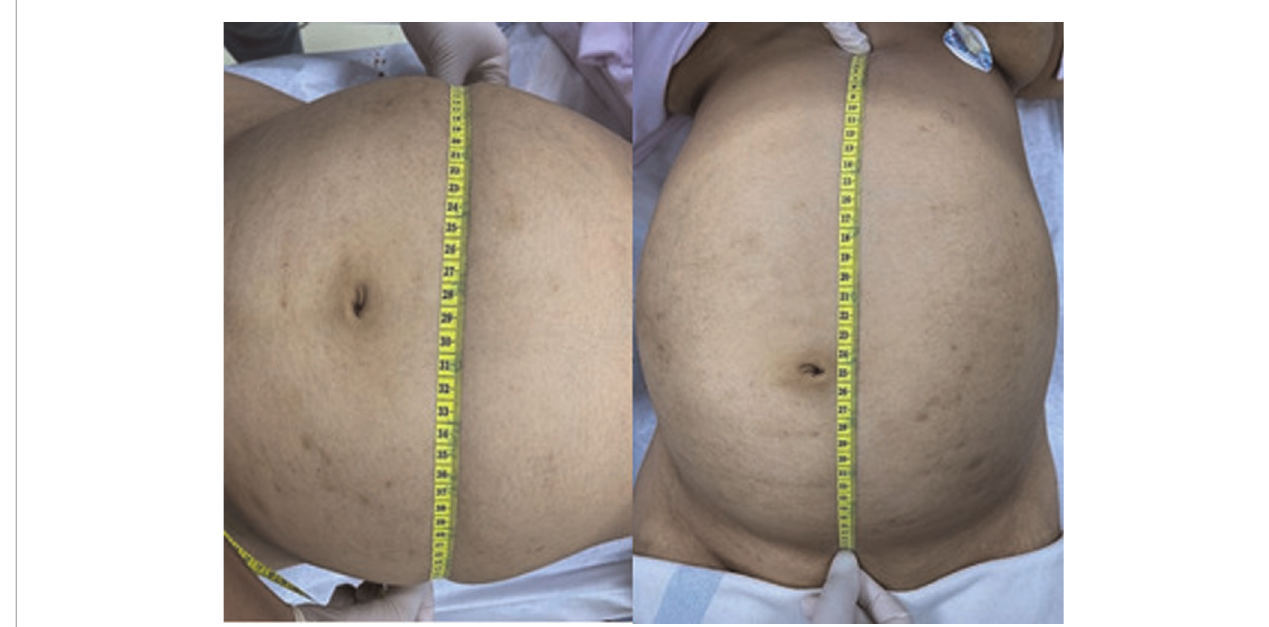
FIGURE 1 | Measurement of the abdominal mass during physical